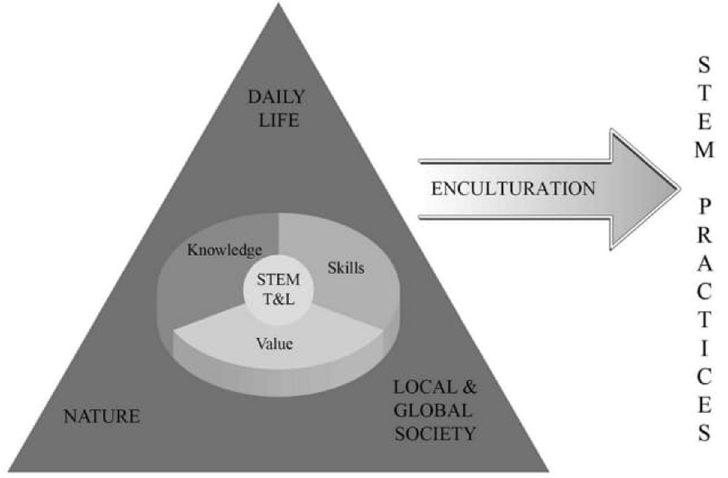
Fig 1. Framework for STEM teaching practices